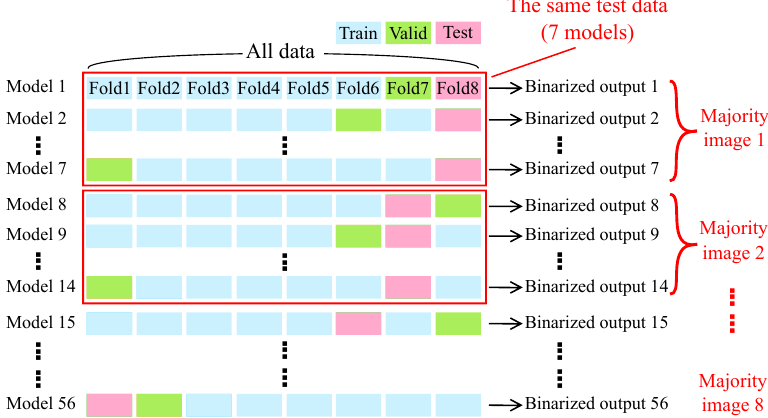
Figure 2. Overview of ensemble learning (majority voting